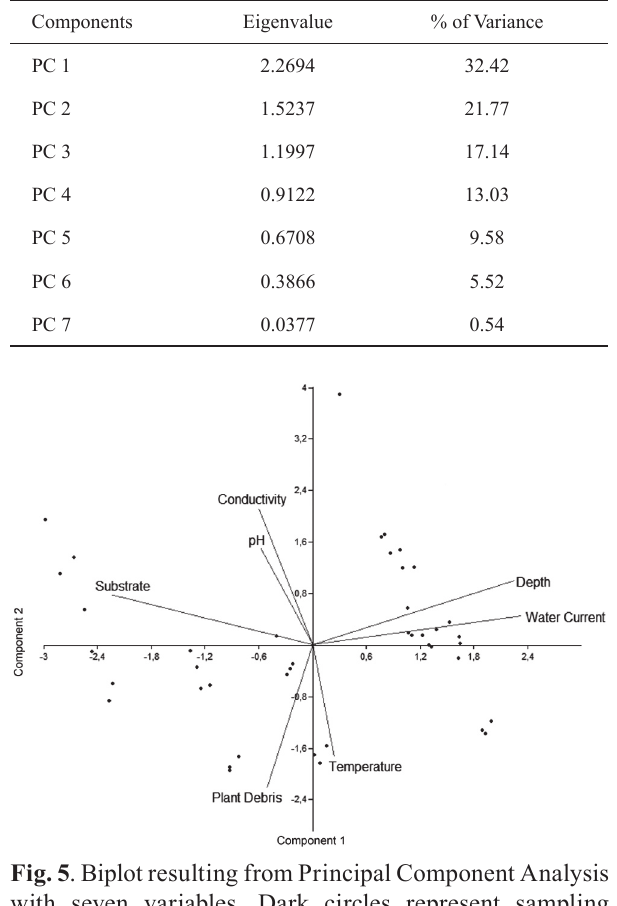
Table 4. Eigenvalues and percentual of variance resulting from Principal Component Analysis of population densities of Eigenmannia vicentespelaea and seven environmental variables.